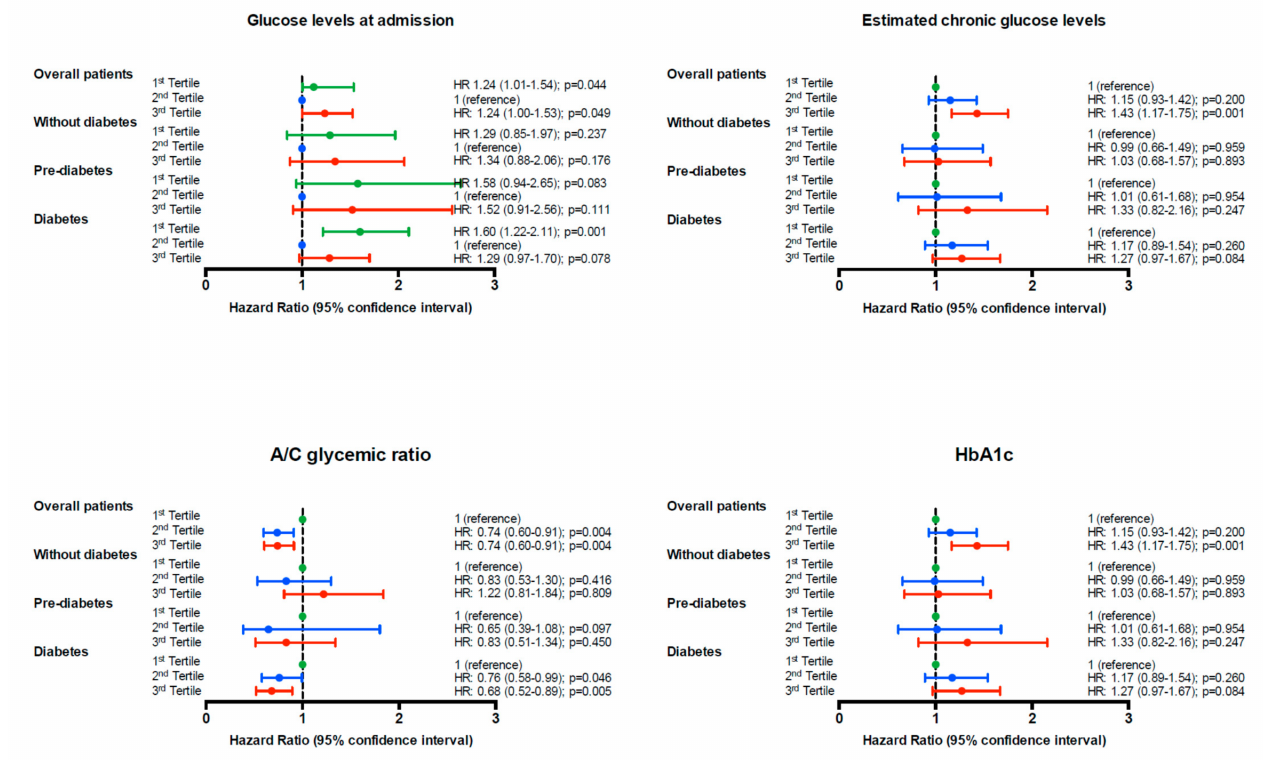
Figure 4. Unadjusted hazard ratio (95% CI) of the end point (4-year mortality for all-cause) grouped according to tertiles (first tertile: green, second tertile: blue, third tertile: red) of glucose levels at admission, estimated chronic glucose levels, the acute to chronic glycemic ratio, and HbA1c in the whole population and stratified according to glucose